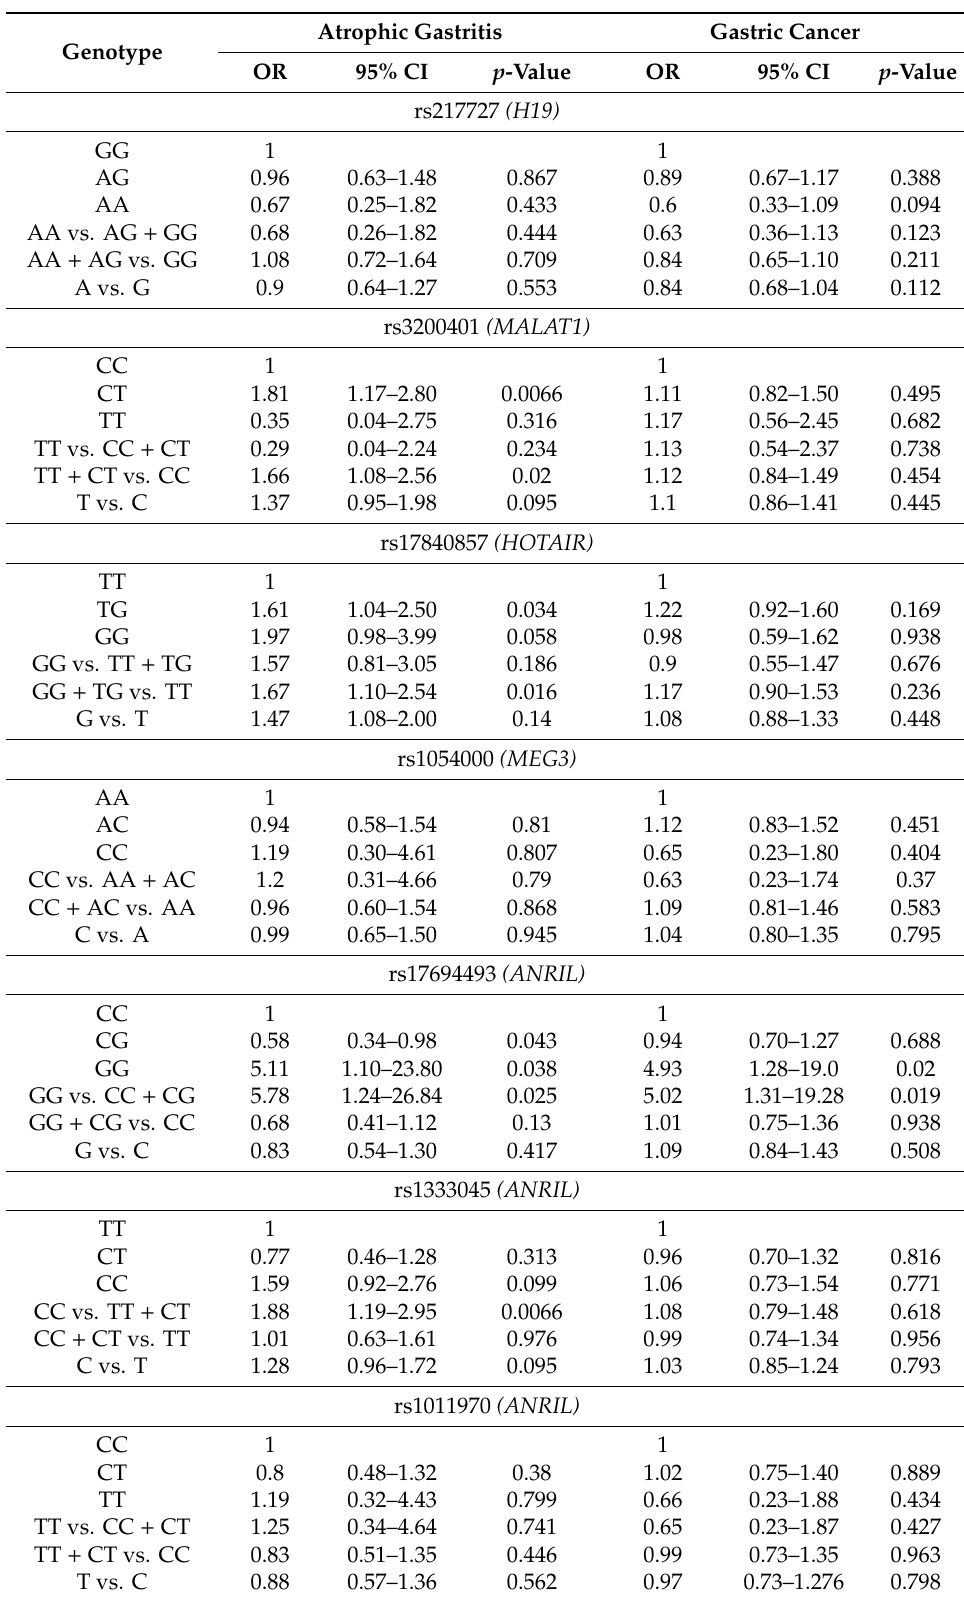
Table 4. Odds ratios of atrophic gastritis and gastric cancer by